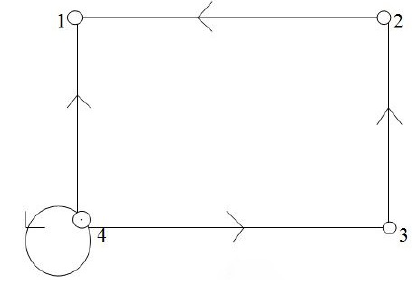
Figure 3. A graph defined via the elements of a metric space and edges satisfying a metric